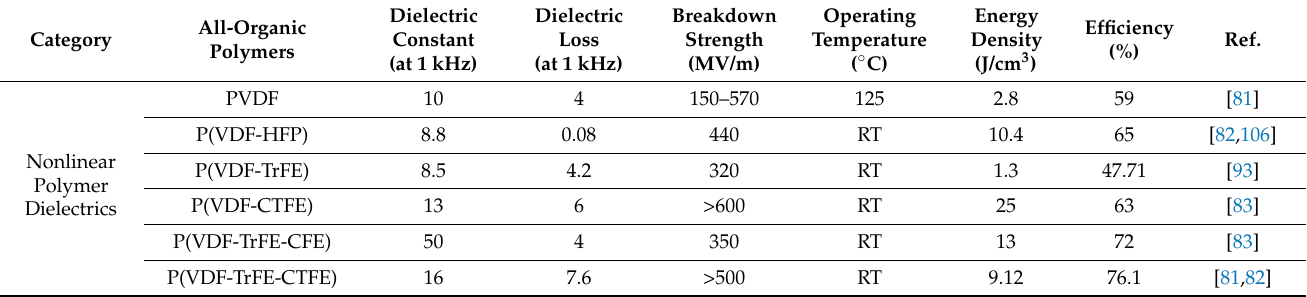
Table 3. Dielectric and Energy Storage Properties of Nonlinear Polymer